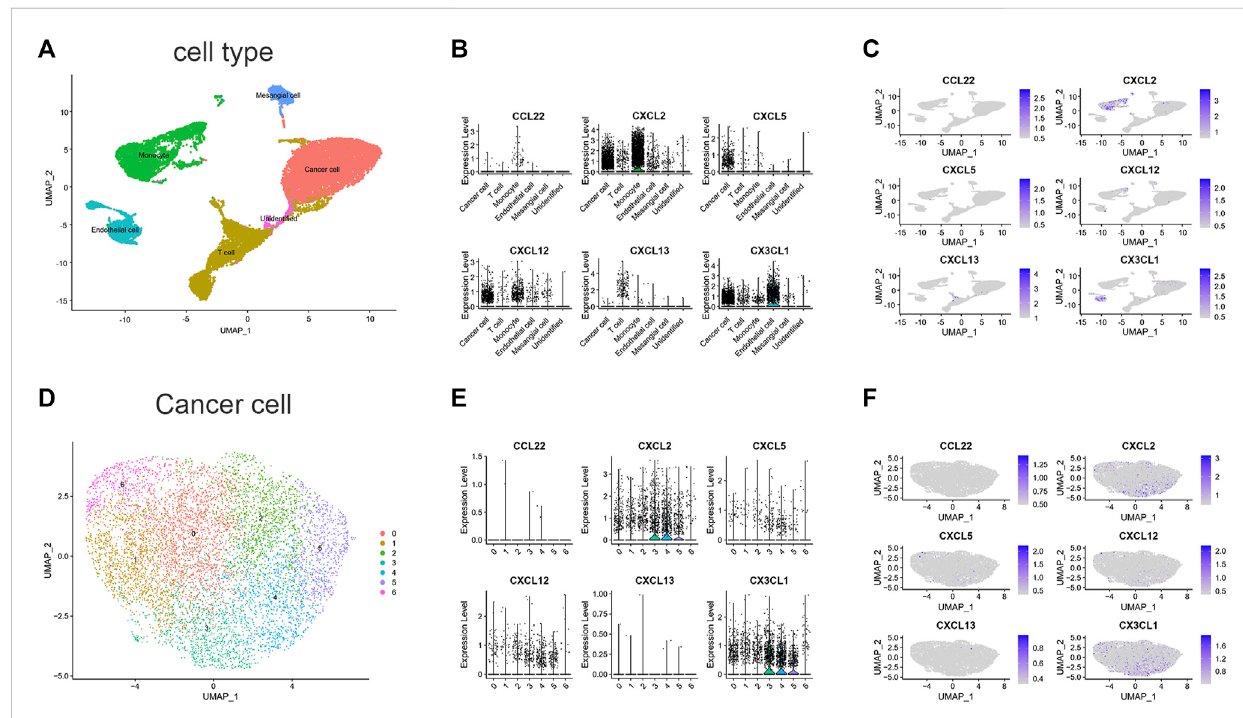
FIGURE 6 scRNA-seq data analysis in GSE152938. (A) Cell-type annotation of clusters. (B) Signature genes expression levels in several cell subtypes. (C) UMAP showsexpressionofsignaturegenesinallcellsubtypes. (D) SubtypesofCancercells. (E) Signaturegenesexpressionlevelsindifferentsubtypesofcancer cells. (F) UMAP shows expression of signature genes in subtypes of cancer cells. (CCL11 is